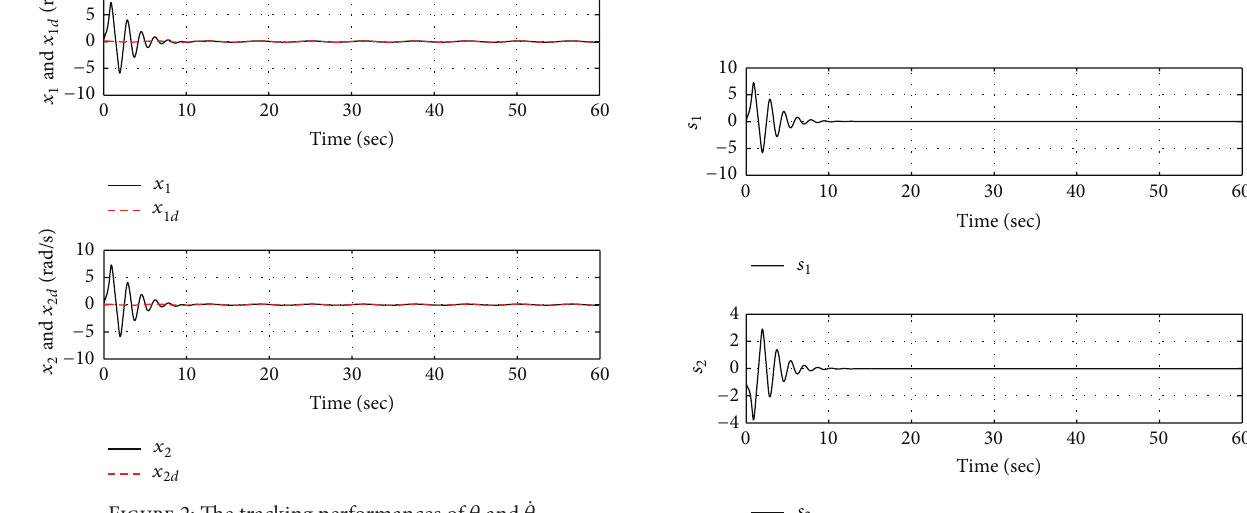
Figure 2: The tracking performances of 𝜃 and